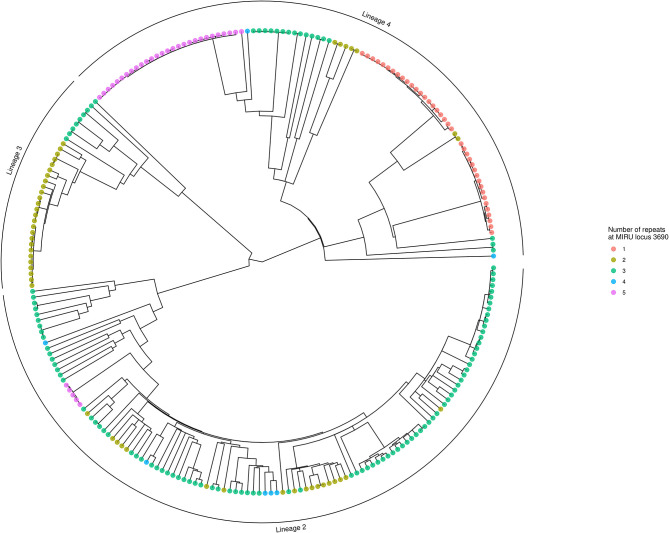
Phylogenetic tree showing number of repeats at locus 3690. The tree is identical to that shown in Figure 3, except tips are colored to designate the number of repeats at locus 3690 for each isolate. Numerous instances of homoplasy are seen in Lineages 2 and 4. The tree was generated using R ggtree (41).